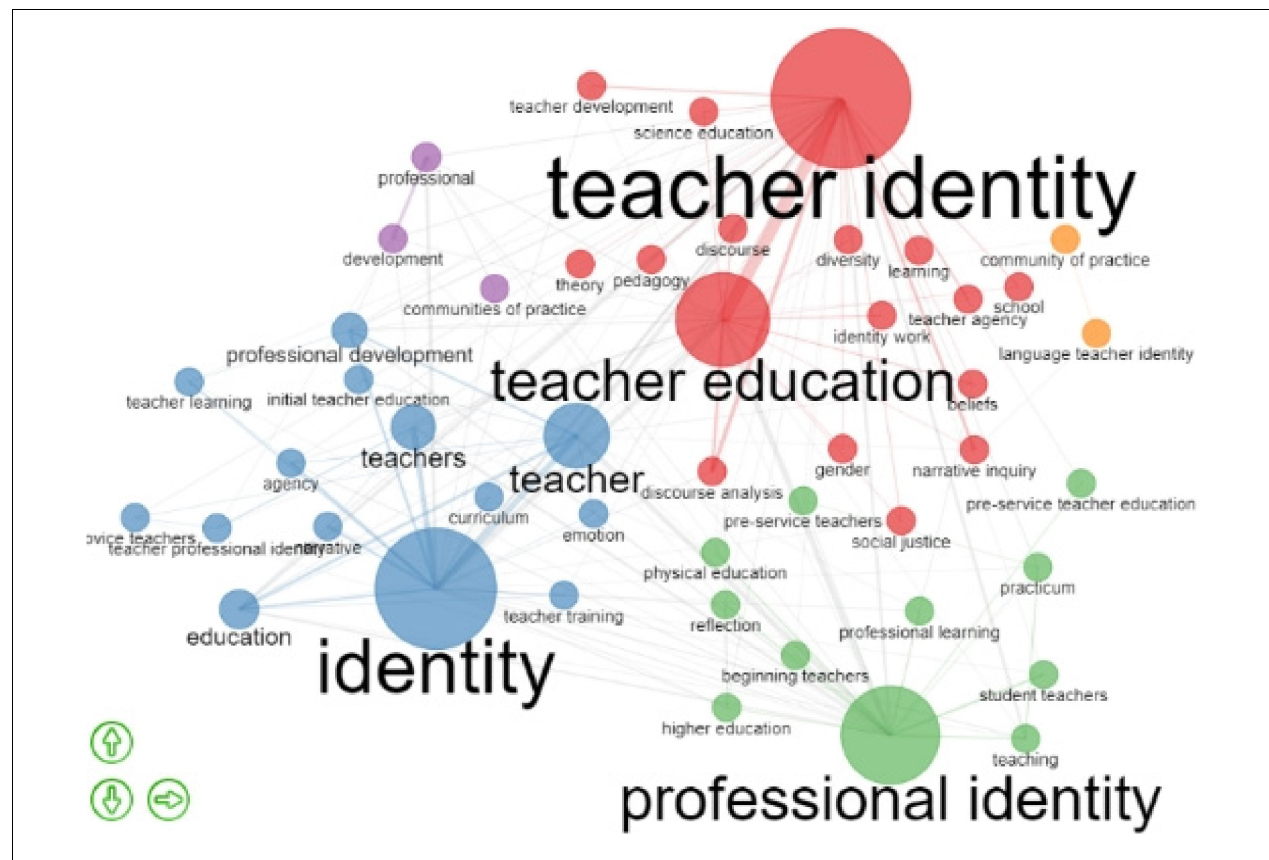
FIGURE 10 | Co-occurrence of author’s keywords.